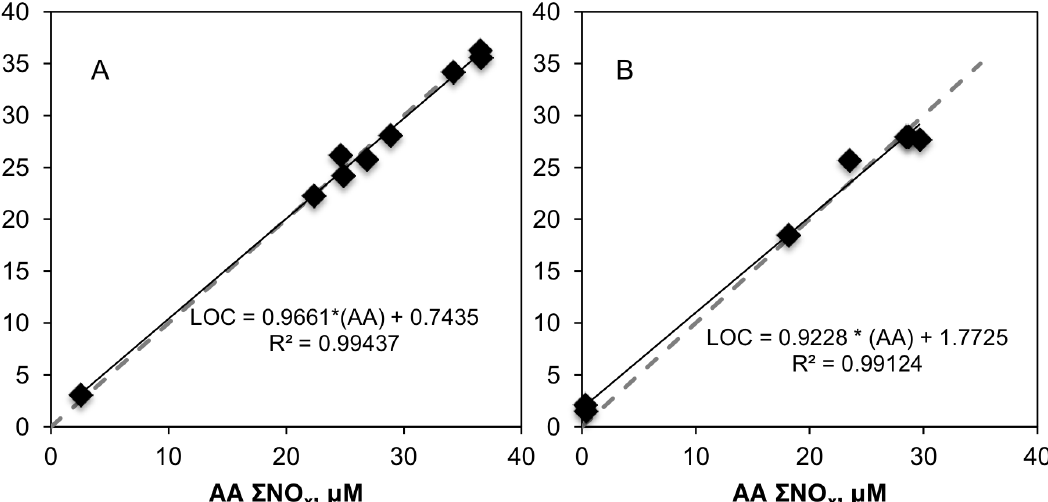
Fig 2. Comparison of autoanalyzer (AA) and LOC measurements (A) Autoanalyzer and LOC Σ NO x measurements on samples obtained from hydrocast CTD#2, from 1000 m. Here, LOC was operated on a shipboard laboratory bench. (B) Autoanalyzer and in situ LOC Σ NO x measurements on samples obtained from hydrocast CTD#16, from 170 m.